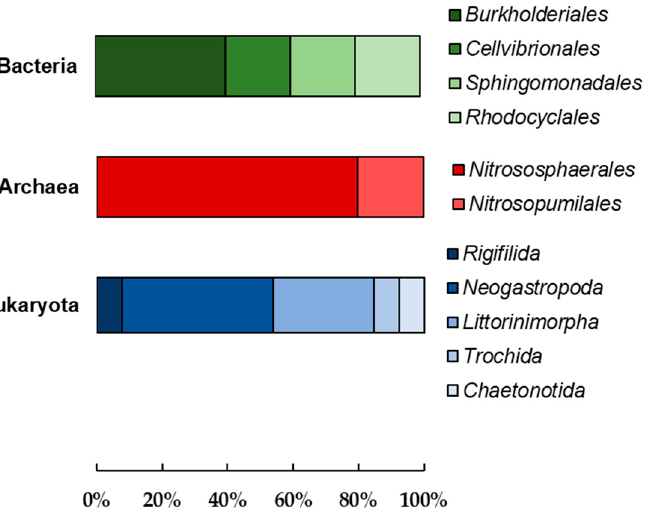
Figure 6. Relative abundance of microbial taxonomy (order) of the clones obtained from Mn (IV) biofilm-colonized pebbles collected from a stream in Snowdonia, UK, based on archaeal and bacterial 16S and eukaryote 18S rRNA genes.